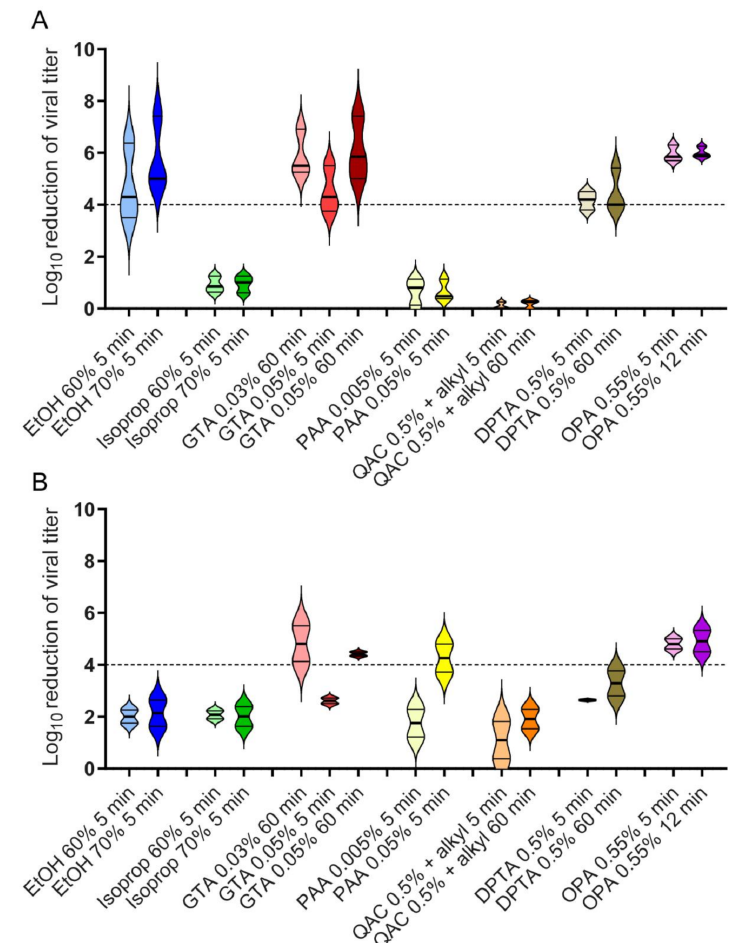
Figure 4. Activity of chemical disinfectants against HPV16 pseudovirus and SV40. The results from quantitative suspension tests with ( A ) HPV16 pseudovirus and ( B ) SV40 and chemical disinfectants are shown as the reduction factor (RF). Tests were performed at 20 ◦ C ± 2 ◦ C with 0.3 g/L BSA as an interfering substance. The data are an average of n = 3 experiments for HPV16 pseudovirus conducted in one laboratory (Cologne). In the case of SV40, n = 6 experiments were conducted as three independent experiments in two different laboratories (Stuttgart and Bremen). The error bars show the standard deviation. The dashed line indicates a ≥ 4 log 10 reduction in virus titer after different contact times, corresponding to a minimum of 99.99% inactivation. Alkyl: